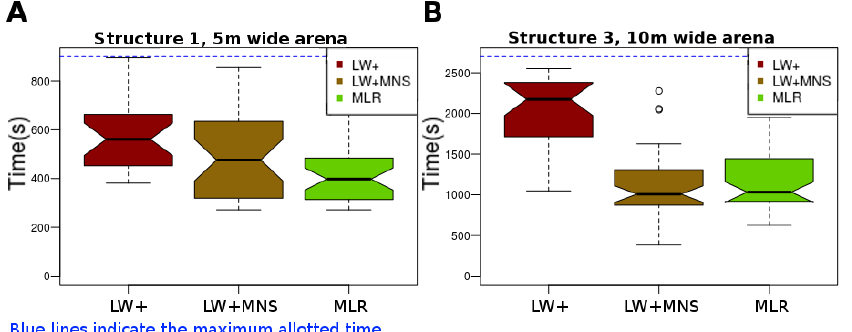
Figure 8. ( A ) Structure 1, run in a corridor of 5 metres width, with a null hypothesis that the different strategies would have the same performance. Amongst those simulations that did not time out, LW+MNS and MLR have statistically significantly superior performance to LW+, p -values of 0.062 and 5.6 × 10 − 3 . Compared to the simulations in the 3 m wide space, all strategies see an improvement in performance, likely due to the unrecruited robots during later stages of assembly being able to more-easily pass around the structure to reach whichever parts of it are still recruiting. The LW+, LW + MNS and MLR strategies had, respectively, time-out rates of 29%, 13% and 3%. ( B ) Structure 3, run in a corridor of 10-m width and using a population of 30 robots. Earlier runs performed with all strategies for structure 3 in a 3 or 5 m corridor mostly timed out; hence, the cut-off time was increased to 45 min and the scenario re-run with a wider corridor and increased robot population. With these adjustments to the scenario, to ensure that a high proportion of simulations managed to complete within the time limit, a strong advantage can once again be seen for the LW+MNS and MLR strategies over LW+. Consideration across S1, S2 and S3 structures shows that the superiority of dynamic self-assembly strategies appears to be maintained regardless of structure size. p -values of 3.6 × 10 − 10 and 2.0 × 10 − 9 for LW + MNS and MLR, respectively, against LW+ show that “in motion”